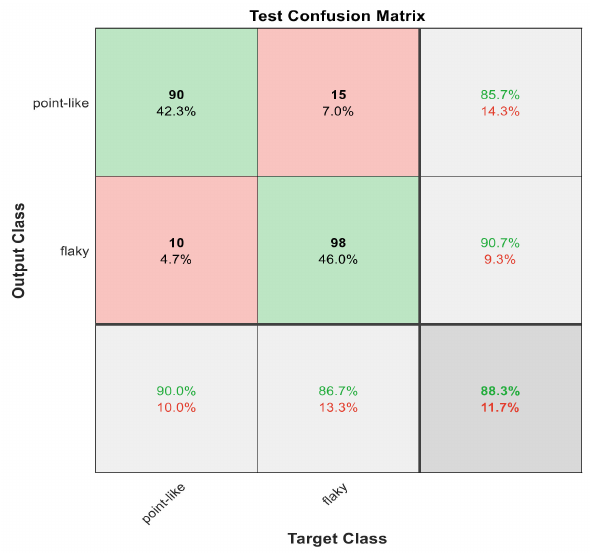
Figure 18. The confusion matrix for Model 1 using 1000 deep learning